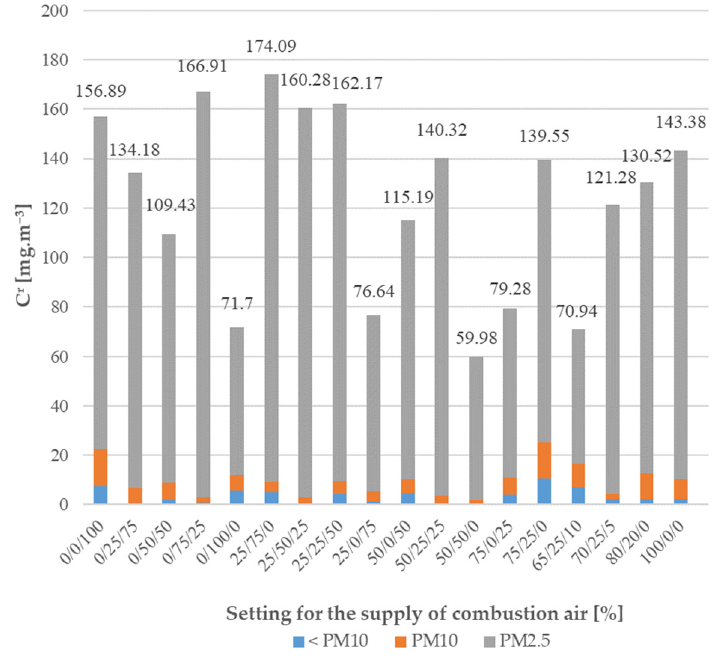
Figure 7. The formation of particulate matter during different settings for air supply. The calculated average value of standard deviation was ± 26 mg · m − 3 for particulate matter. This value is higher, caused probably by automatic regulation of the flow based on the velocity of the flue gases necessary for isokinetic condition, then by change of pressure ratios on the chimney and in the space (for example caused by open windows) and by a slow reaction of the flow rate to velocity